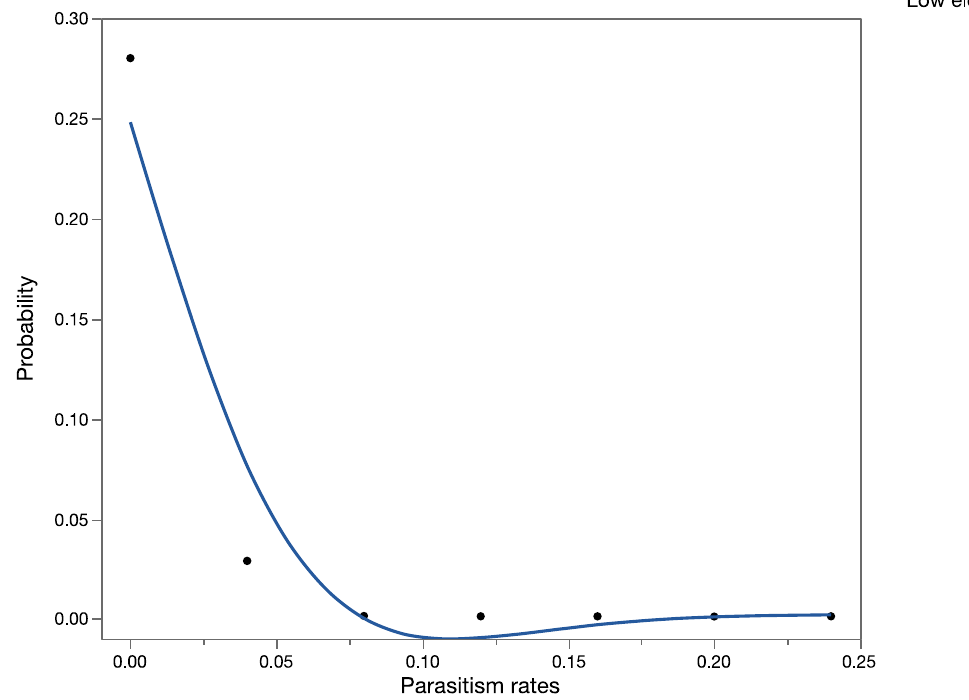
Figure 7. Forecast of all possible parasitism rates (as a proportion on the x -axis) for T. flavoorbitalis at low-elevation sites using published data.